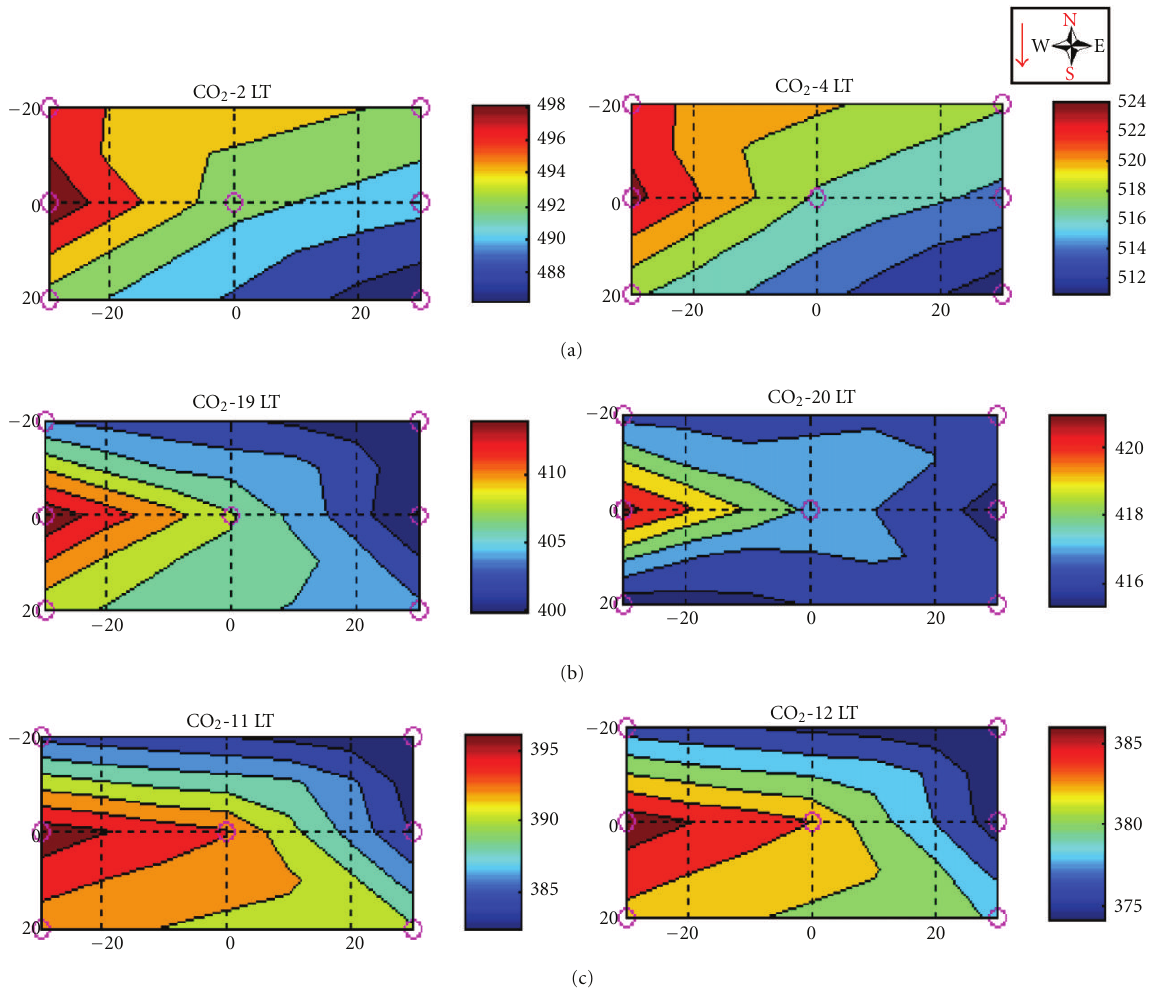
Figure 18: Hourly average of the subcanopy (2m) CO 2 concentration on the DRAINO system north face area during dry period of the year 2006. Note the geographic orientation and the red arrow indicating slope inclination (see Figure 4). The axis represents distances from center of the main tower. Daytime (a), transition period-evening (b), established nighttime